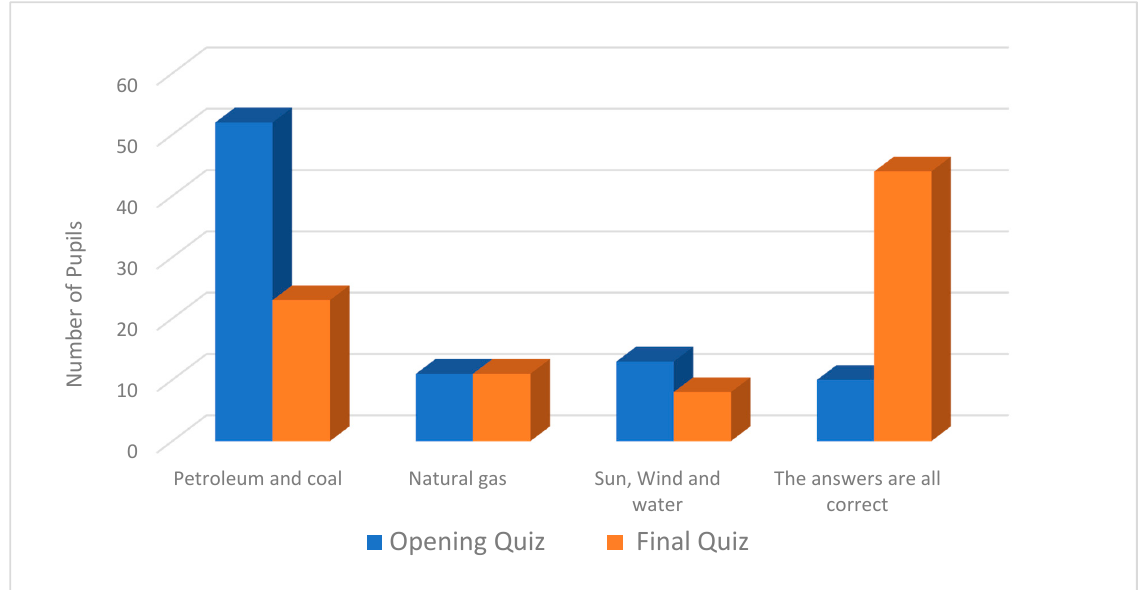
Figure 5. Results for the question “which of the following can be used as a source of energy?”.